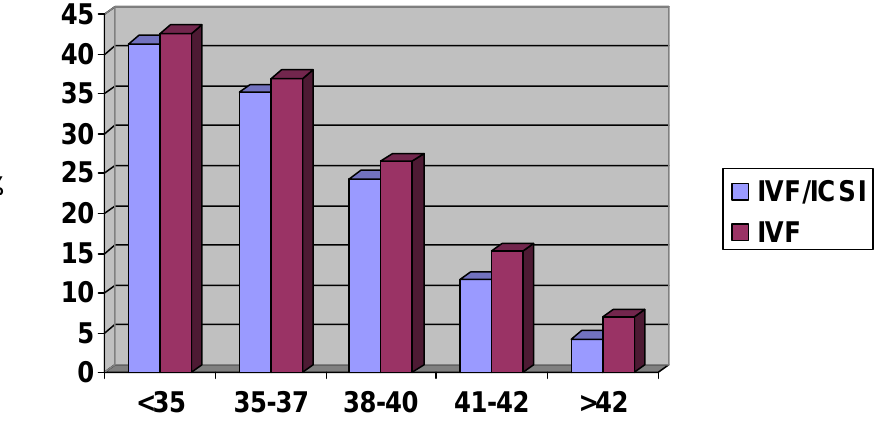
FIGURE 1 . Percent live births per retrieval by woman's age (from 2002 CDC/SART